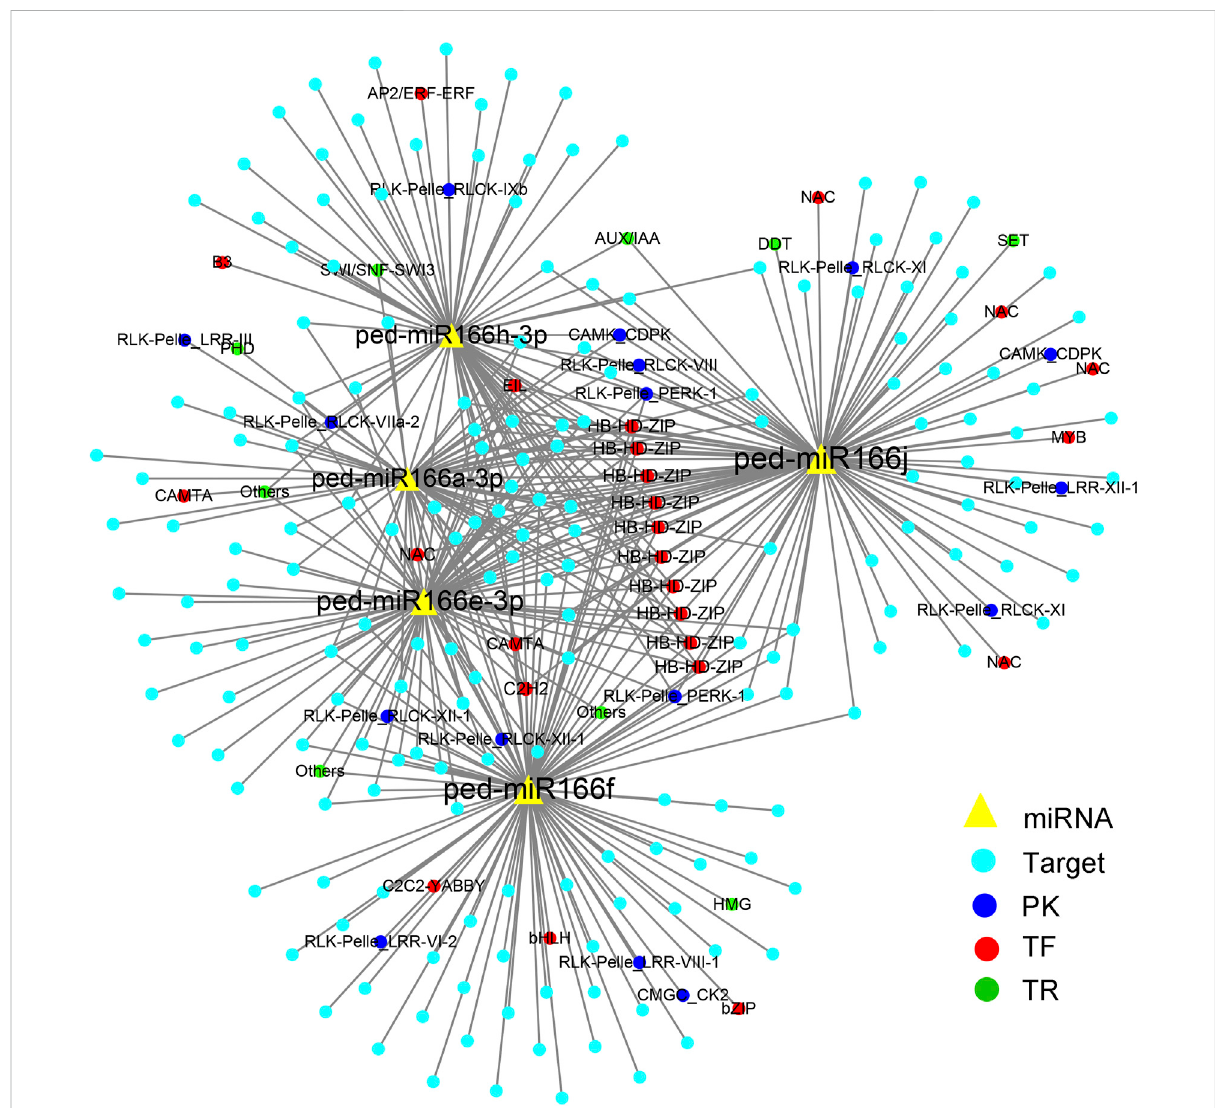
FIGURE 3 Cytoscape regulatory networks of fi ve overexpressed miR166s and their predicted targets. Yellow triangles indicate miRNAs; blue solid circles indicate target genes. Targets that encode protein kinases are indicated by deep blue circles, transcription factors are indicated by red circles, and transcriptional regulators are indicated by green